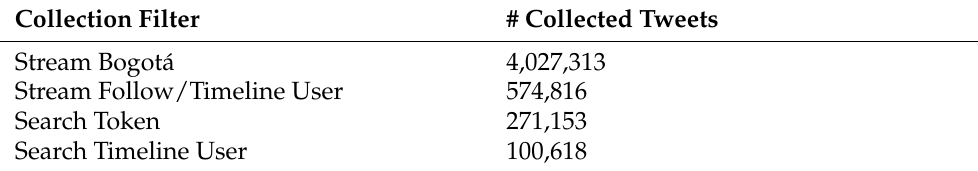
Table 4. Number of tweets collected by filter.